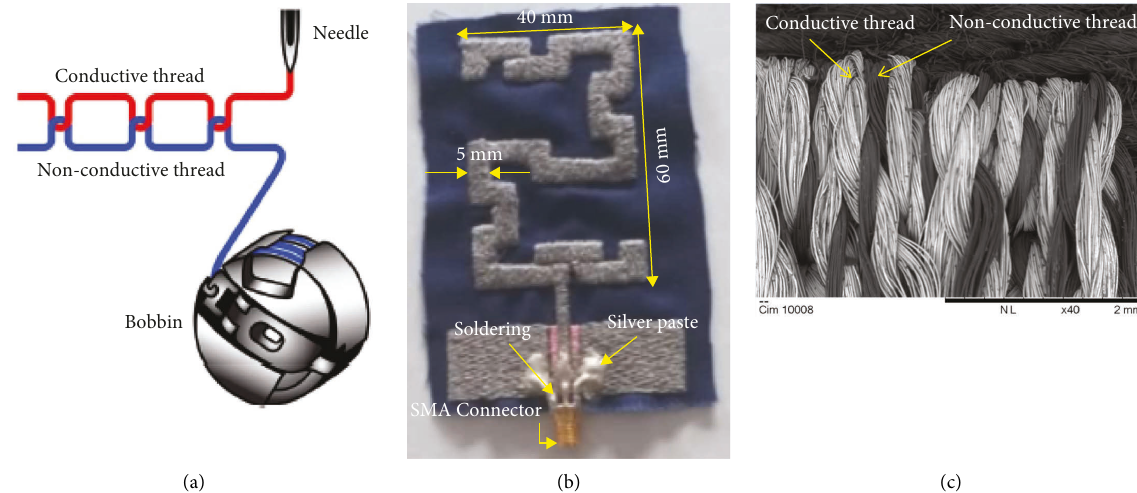
Figure 4: (a) Bobbin with top conductive thread and bottom looper thread to be inserted in the lower half of an embroidery machine; (b) fabricated Z -shaped meander-line monopole textile antenna; (c) SEM image showing the interlacement of the conductive and nonconductive threads during the embroidery